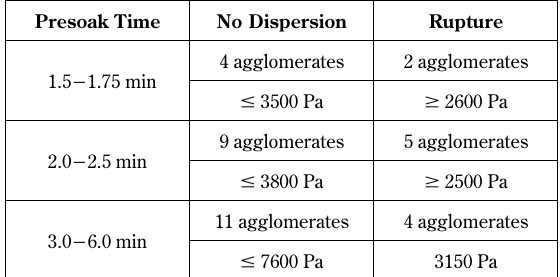
Table 3 Summary of the results of oscillatory shear experiments with hydrophilic agglomerates. The erosion mode of dis- persion was never